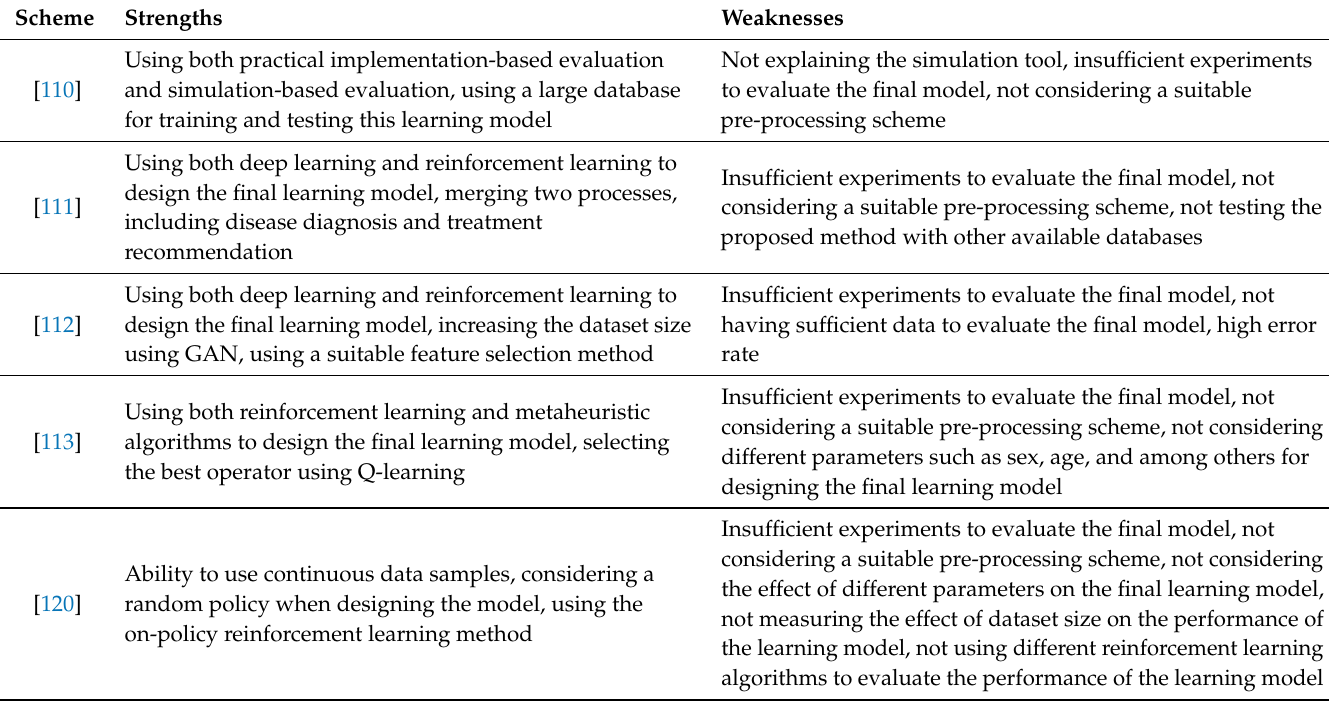
Table 11. The most important strengths and weaknesses of reinforcement learning